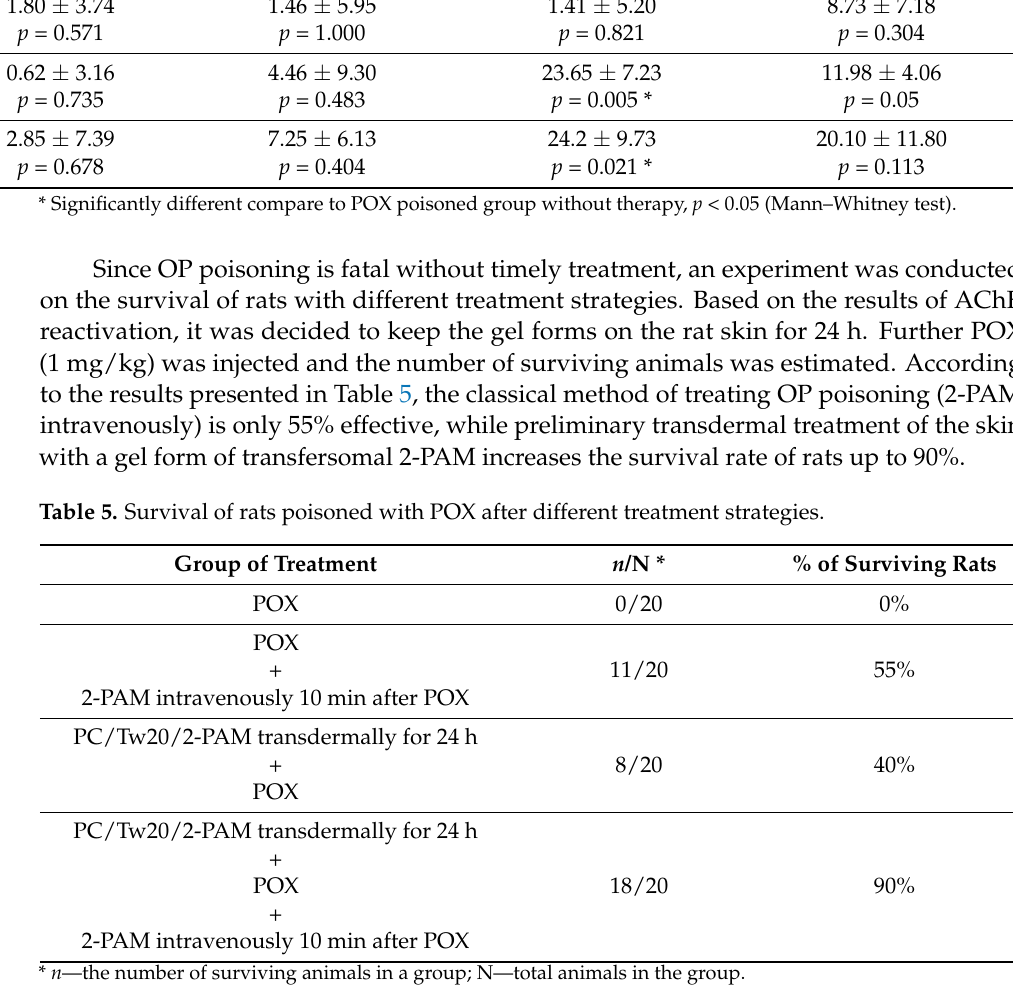
Blood Sampling Time after